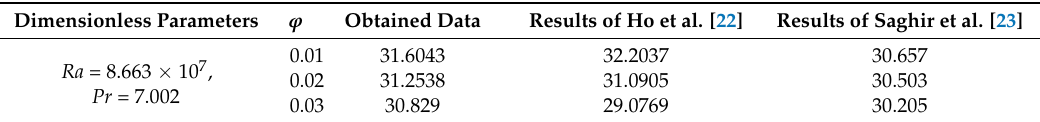
Table 1. Mean Nu at heated border compared with results of other